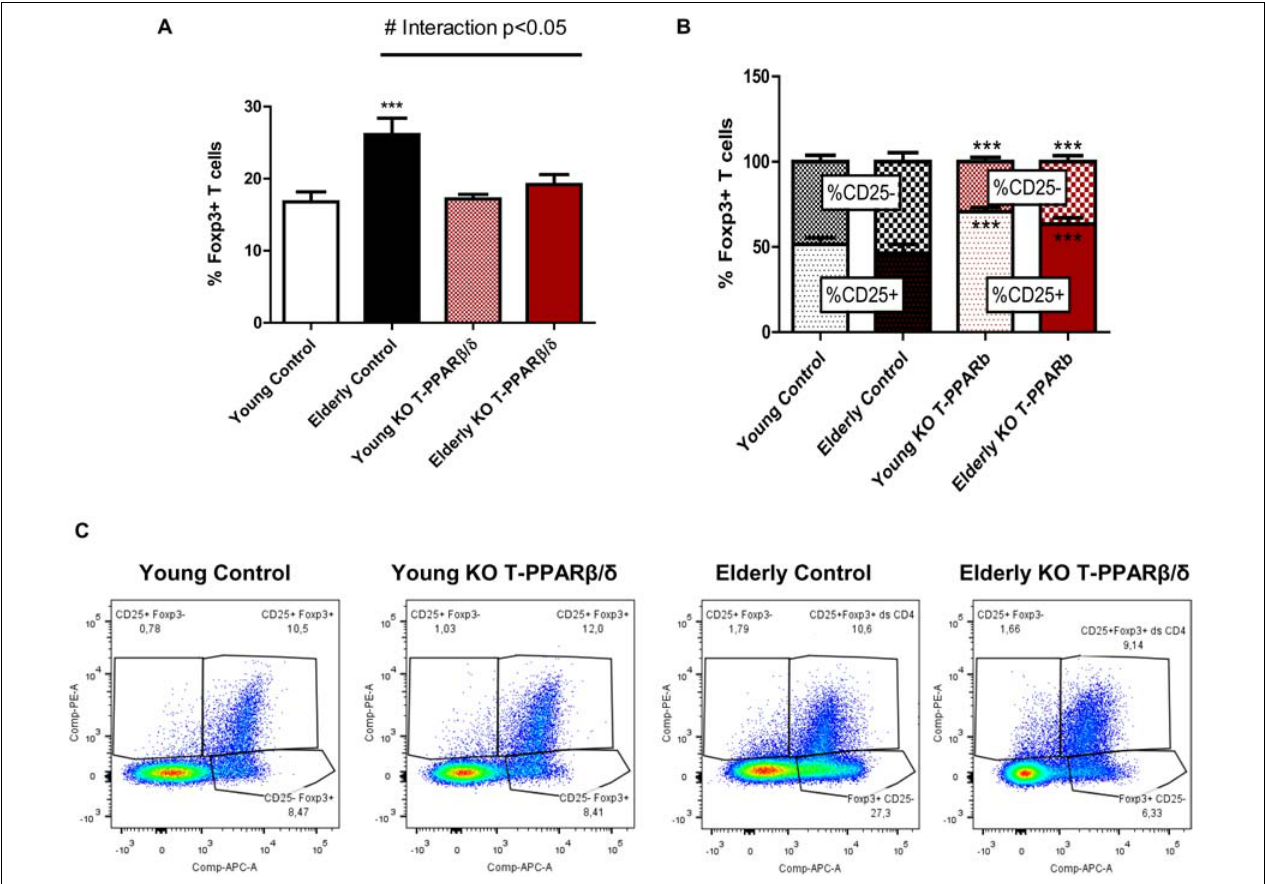
FIGURE 3 | Invalidation of PPAR β / δ in T cells preserves prevalence of FoxP3 + Tregs in lymph nodes with age. Percentage of (A) labeled FoxP3 + Tregs in CD3 + CD4 + T and (B) of the subpopulations CD4 + CD25 - and CD4 + CD25 + of FoxP3 + Tregs cells, in young and older mice invalidated for PPAR β / δ in T cells (KO-T PPAR β / δ ) or not (control). (C) Representative flow cytometry dot plots of CD4 + CD25 + FOXP3 + cells and CD4 + CD25 - FOXP3 + cells among the CD3 + CD4 + T cells in lymph nodes of all mice. Values are mean ± SD. Statistical analysis was performed using a two-way (age and genotype) analysis of variance (ANOVA). # p < 0.05, interaction effect between age and genotype; *** p < 0.005, different from age-matched control mice. Young control ( n = 11); young KO-T PPAR β / δ ( n = 8); older control ( n = 7); Older KO-T PPAR β / δ ( n =